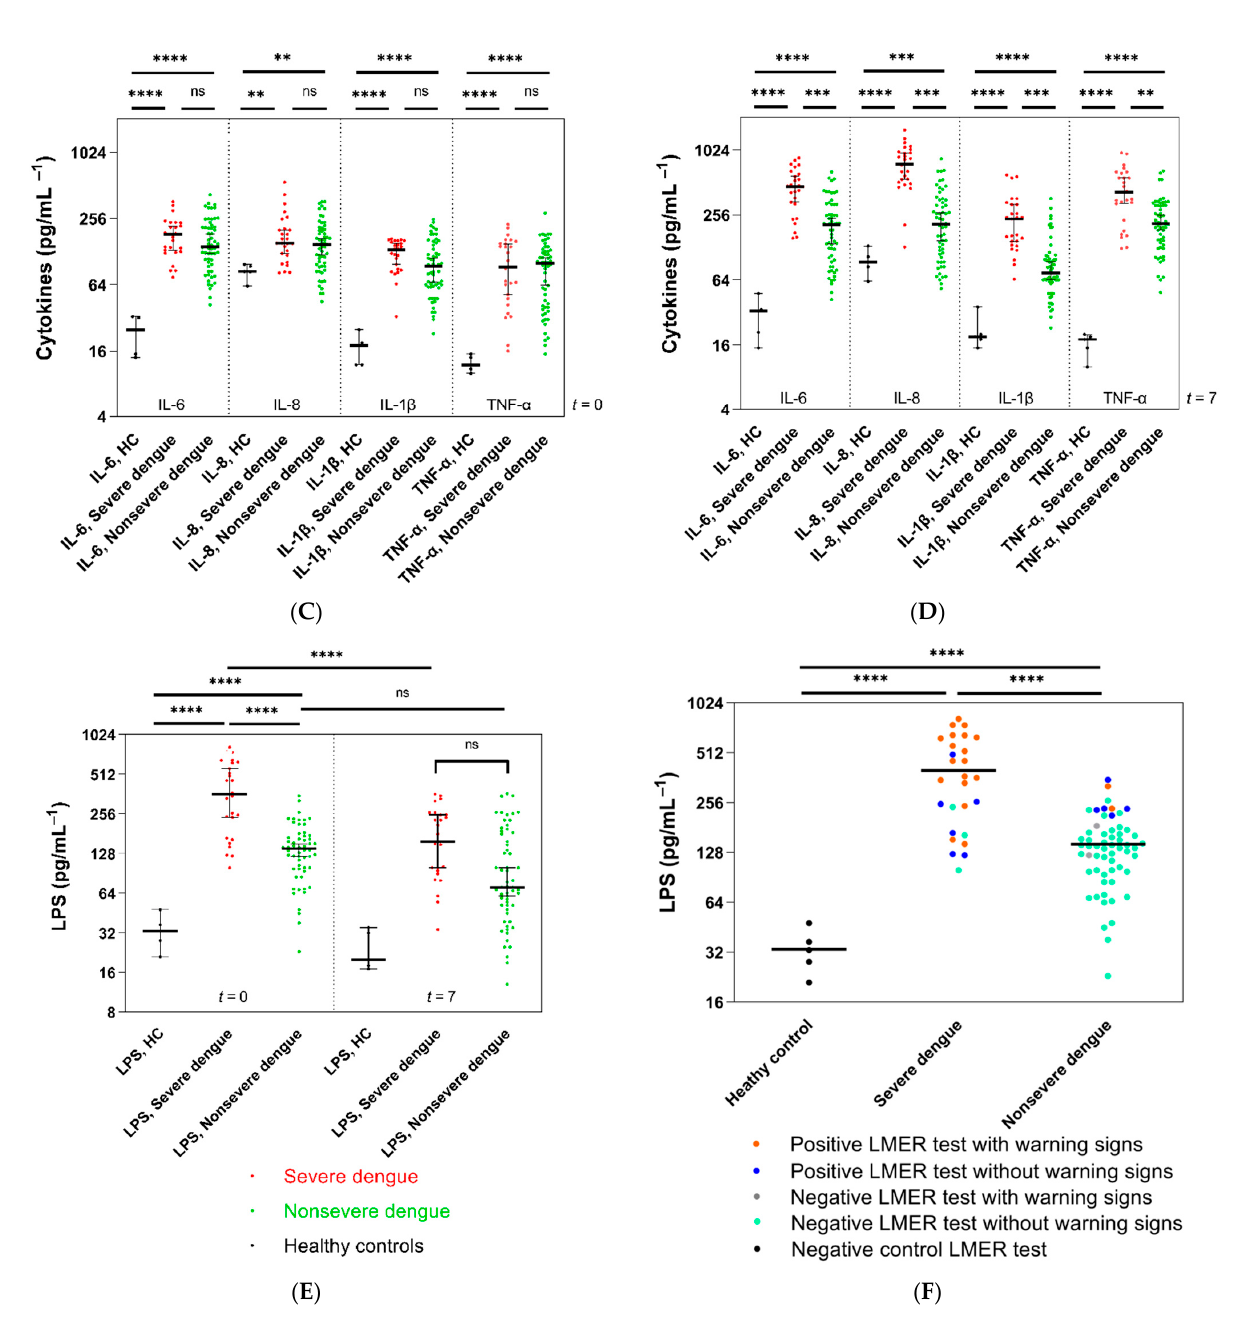
Figure 3. Ranges of measured lipopolysaccharide ‐ binding protein (LBP), (1 → 3) ‐β‐ D ‐ glucan (BG), cytokines, and lipopolysaccharides (LPS) . The detection range of tested serum samples on 1 ( t = 0) and 7 ( t = 7) of admission from patients who developed severe dengue (red, n = 27) and nonsevere dengue (green, n = 59) in comparison with serum samples from healthy control subjects (black, n = 5) is demonstrated. Heavy bars indicate medians, and error bars represent 95 % CIs. Each value is indicated by a dot . Log transforms with nonparametric statistics were performed as skewed data. ( A ) demonstrates a tendency of higher LBP in patients who underwent severe dengue infection compared with those with nonsevere dengue and healthy control subjects at enrollment (significantly decreased LBP in severe dengue patients on day 7). ( B ) demonstrates significantly increased BG levels in severe dengue patients compared with nonsevere dengue patients. ( C , D ) demonstrate significantly higher levels of interleukin (IL) - 6, IL - 8, IL ‐ 1 β , and TNF - α in severe dengue patients than in nonsevere dengue patients and healthy control subjects. ( E ) demonstrates significantly increased circulating LPS in severe dengue infection at enrollment before antibiotic treatment. ( F ) demonstrates that most severe dengue patients had a positive lactulose ‐ to ‐ mannitol excretion ratio (LMER) corresponding to the presence of warning signs at enrollment. (**** p < 0 . 0001, *** p < 0 . 001, ** p < 0 . 01, and * p < 0.05. )